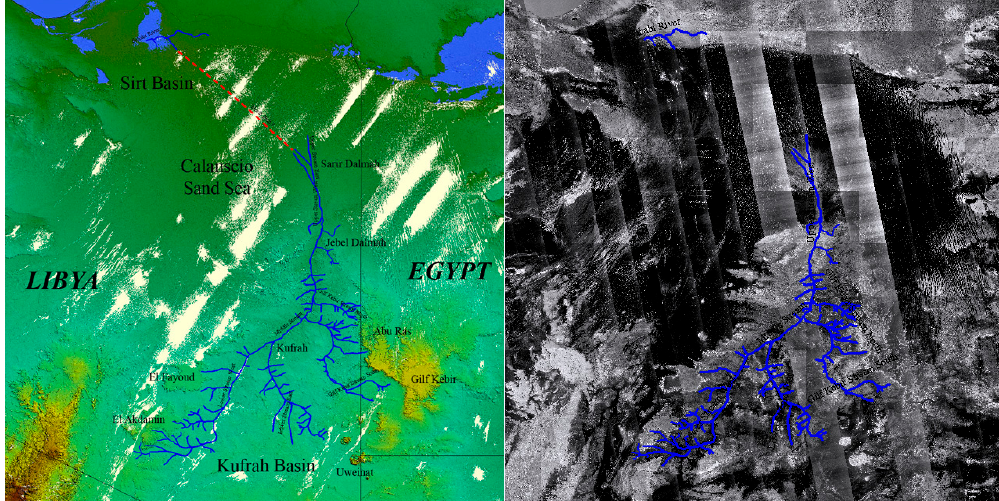
Figure 3. The Kufrah palaeoriver system (in blue) on top of Shuttle Radar Topography Mission (SRTM) topography ( left ) and on top of the PALSAR mosaic ( right ). The red dash line indicates a possible corridor connecting the terminal fan of the Kufrah River to the Mediterranean coast, through the Wadi Sahabi palaeochannel.